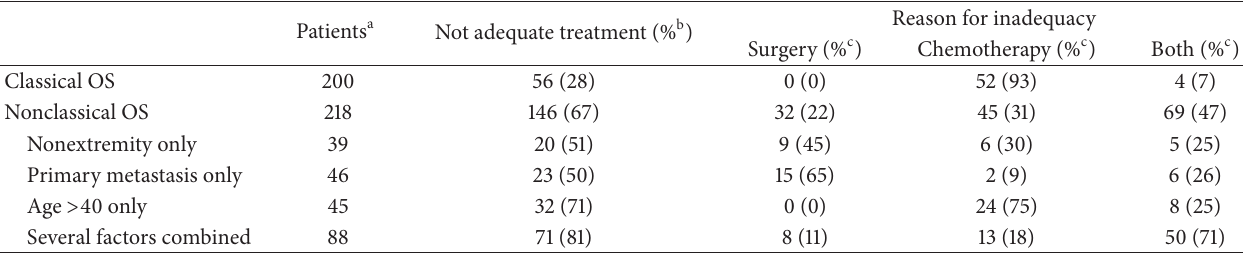
Table 3: Patients who received inadequate treatment dependent of subgroup of high-grade osteosarcoma